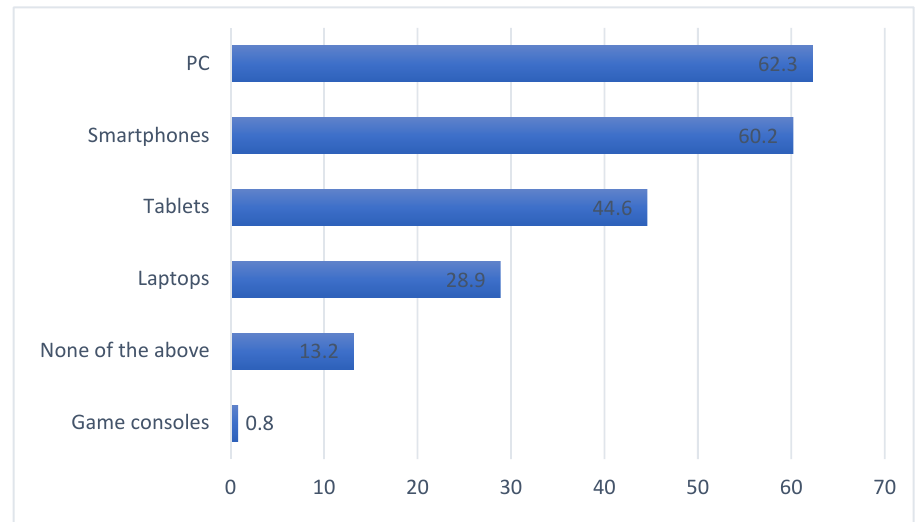
Figure 2. Technologies for games used in the classroom, percentage in respondents, N = 1258.